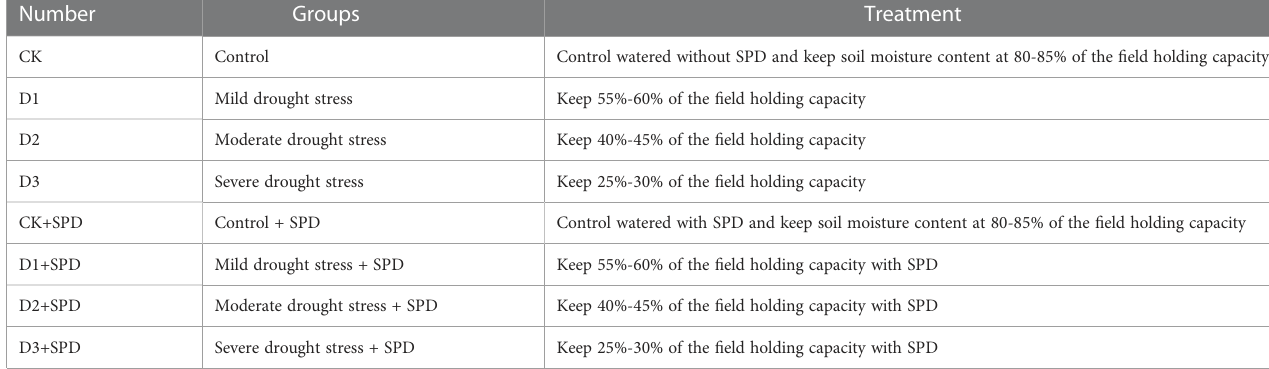
TABLE 1 Treatment